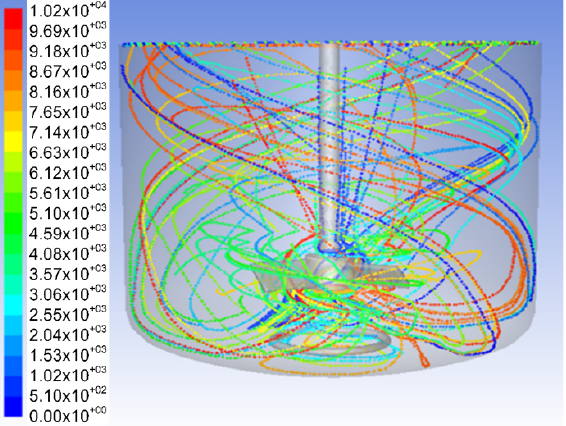
Figure 11. Bubble tracks at N = 400 rpm.